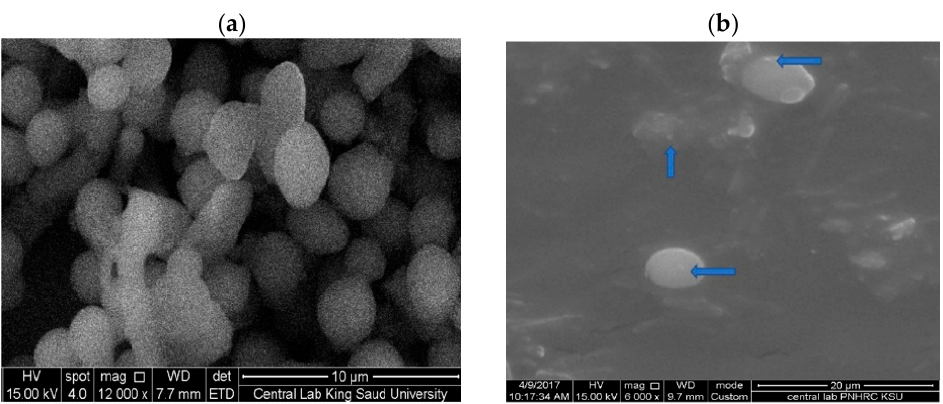
Figure 12. Morphology of untreated C. albicans ( a ) and the morphological changes after application of AgNPs fabricated using O. forsskalii seeds ( b ). The arrows show the AgNPs in the cell surface.